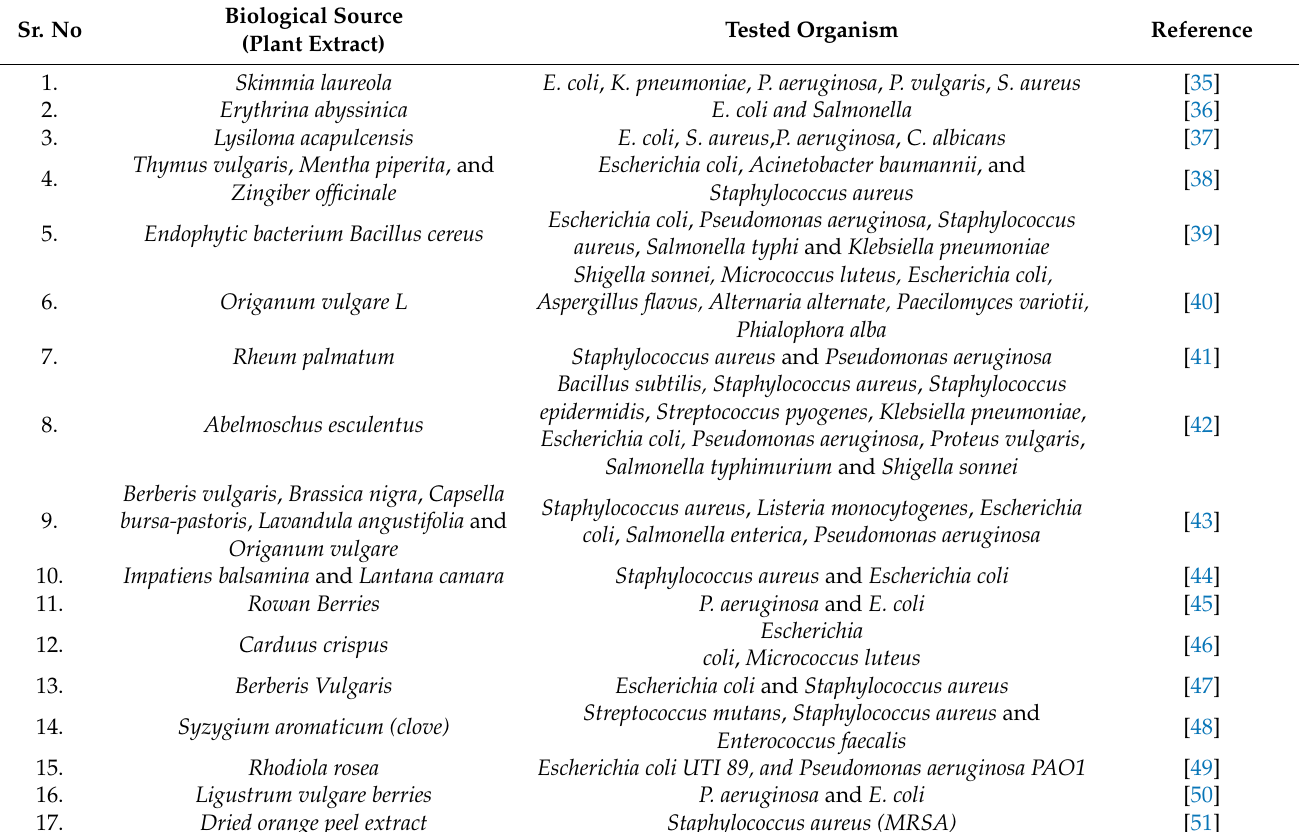
Table 1. Antimicrobial activity of biologically synthesized